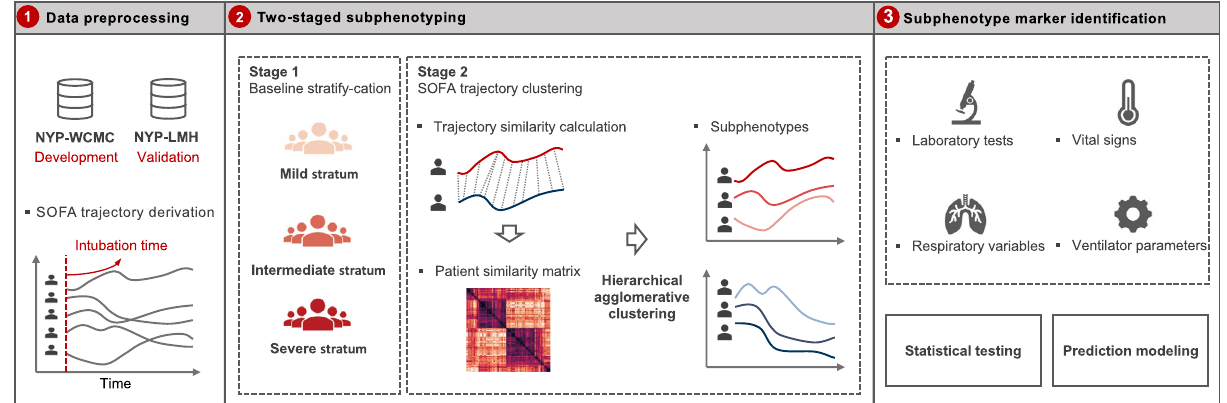
Figure 1. A schematic of the analysis plan. Intubated patients of two cohorts, New NYP-WCMC and NYP- LMH cohorts were analyzed, as development and validation cohorts, respectively. 7-day post-intubation SOFA trajectories were constructed. A two-stage subphenotyping model was then performed on the top of the SOFA trajectories. Statistical testing and prediction modeling were finally performed to identify markers at early stage after intubation for separating the identified trajectory subphenotypes. NYP-WCMC New York Presbyterian Hospital-Weill Cornell Medical Center, NYP-LMH New York Presbyterian-Lower Manhattan Hospital, SOFA Sequential Organ Failure